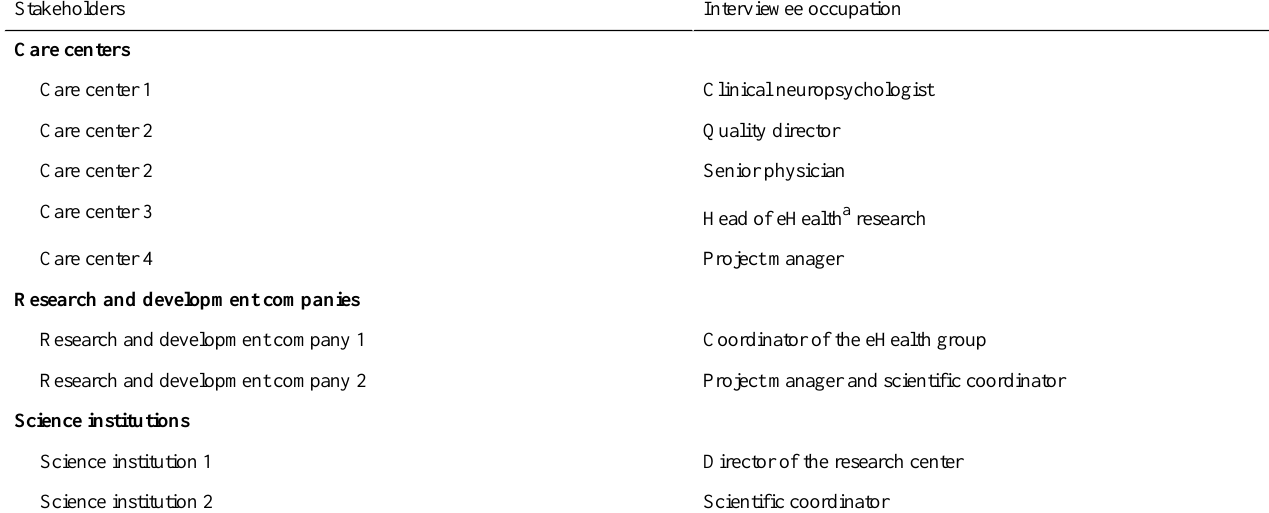
Table 1. Interview